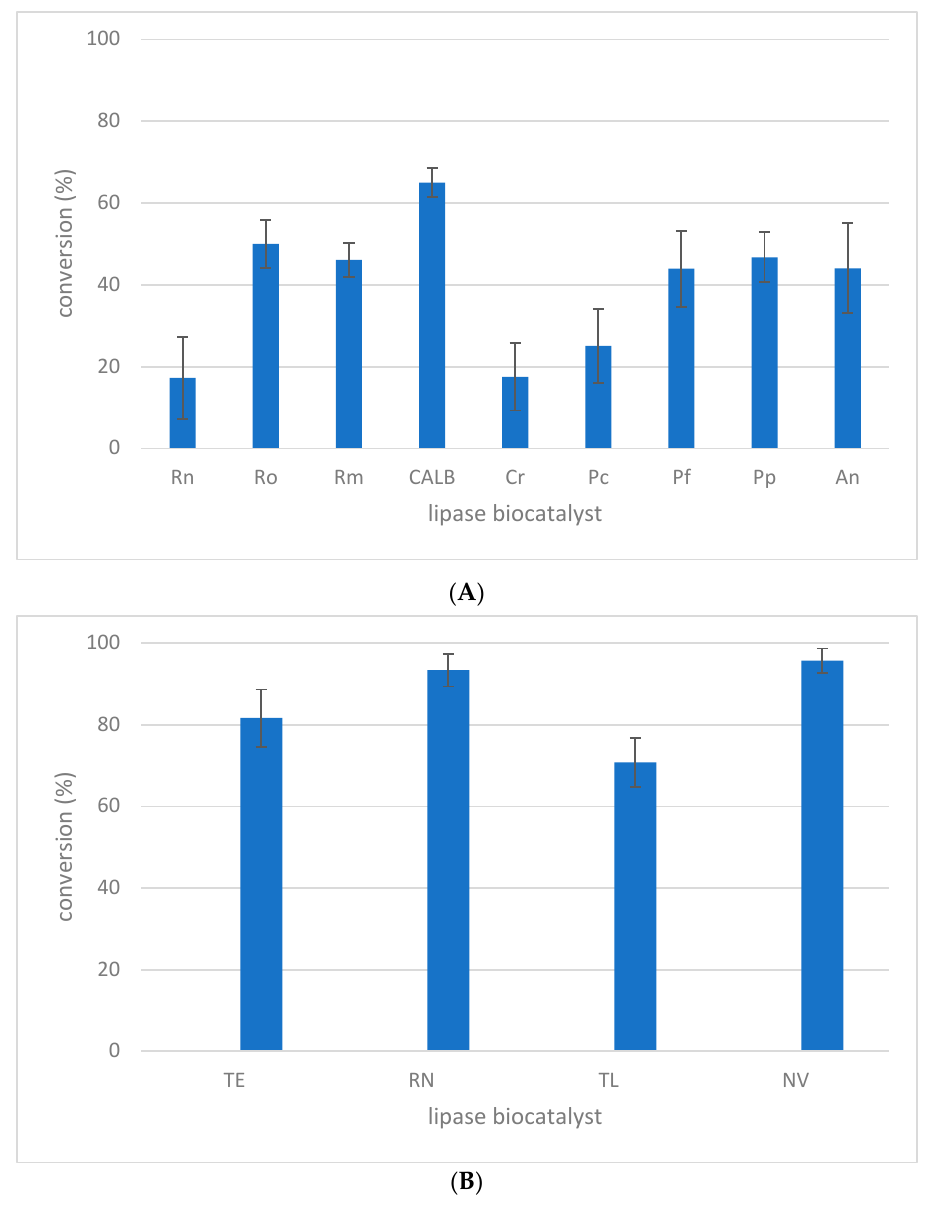
Figure 1. Lipase screening for L -menthol acylation with MLE in M:CA (I) DES medium using ( A ) powdered and ( B ) immobilized biocatalysists. Experimental conditions: 1.58 mM MLE, L -menthol:MLE = 3:1 molar ratio, 1 mg/mL lipase biocatalyst in M:CA (I) reaction medium, 40°C temperature, 1000 rpm shaking, and 24 h reaction time. The values of the error bars were calculated using triplicate measurements.